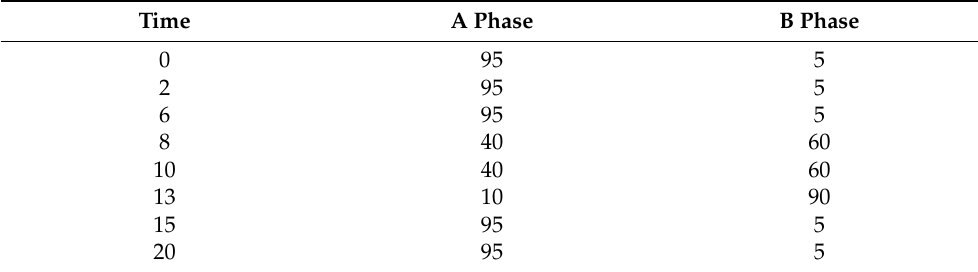
Table 1. Gradient profile for LC to study the degraded organic intermediates for MG